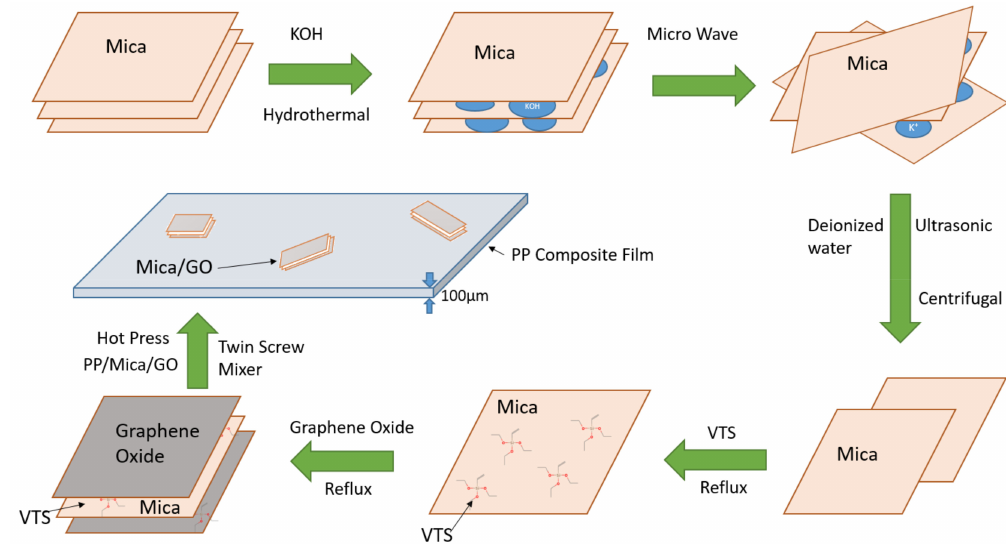
Figure 1. Mica/graphene oxide/polypropylene composite production